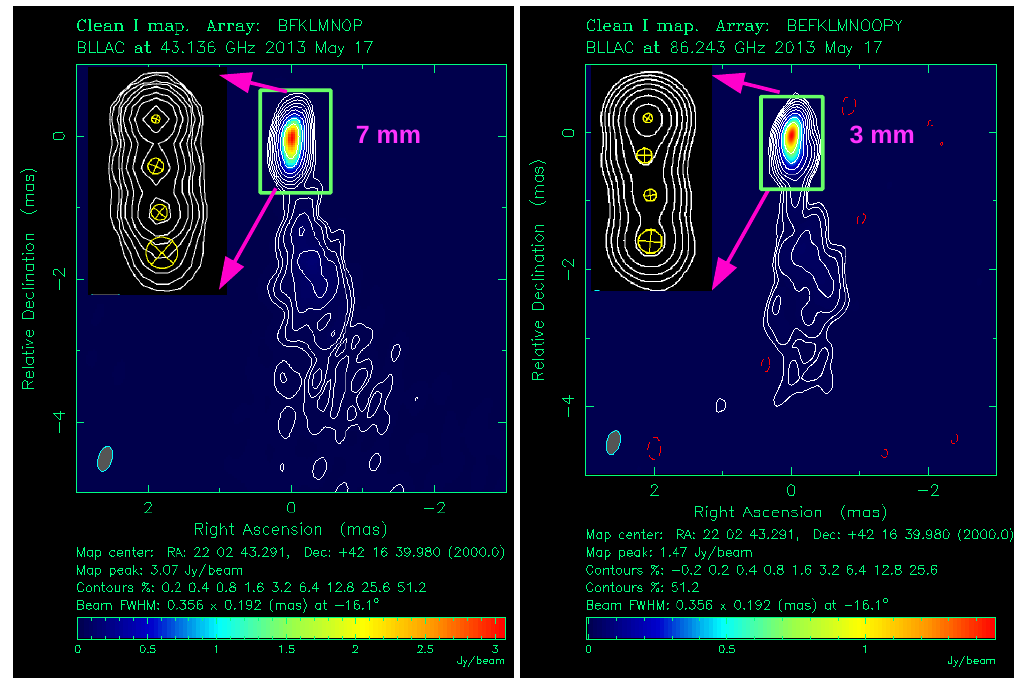
Figure 2. Total intensity maps of BL Lac at 7 mm ( left ) and 3 mm ( right ) radio bands. For comparison purposes the 3 mm map is convolved with the 7 mm beam. A zoomed version (convolved with a beam size of 0.1 mas) of the central region is shown in the upper left corner for each case; the yellow circles are the fitted circular Gaussian components.